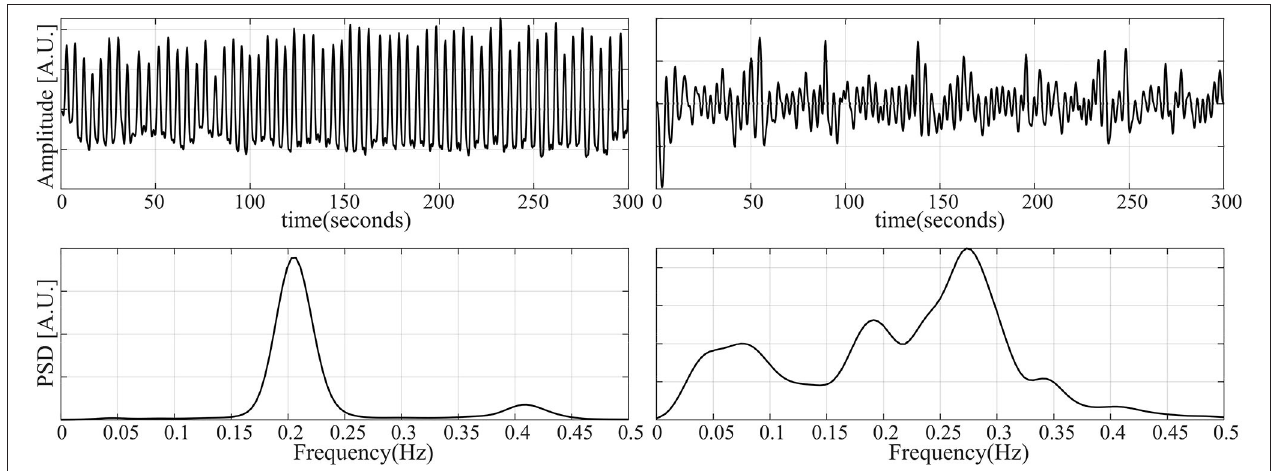
FIGURE 2 | Examples of some of the respiratory segments used in this study. (Left) A case of an epoch free of apnea. (Right) An epoch during an apneic event.